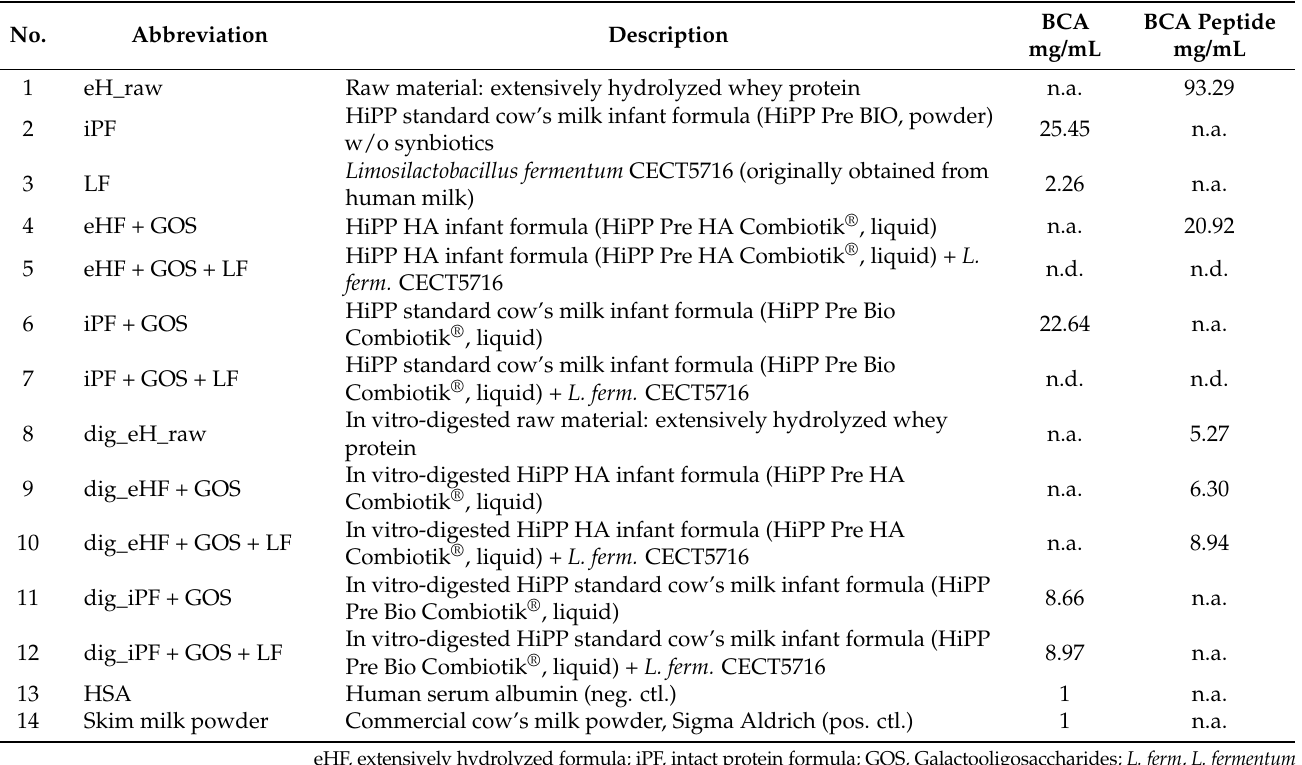
Table 2. Description of investigated